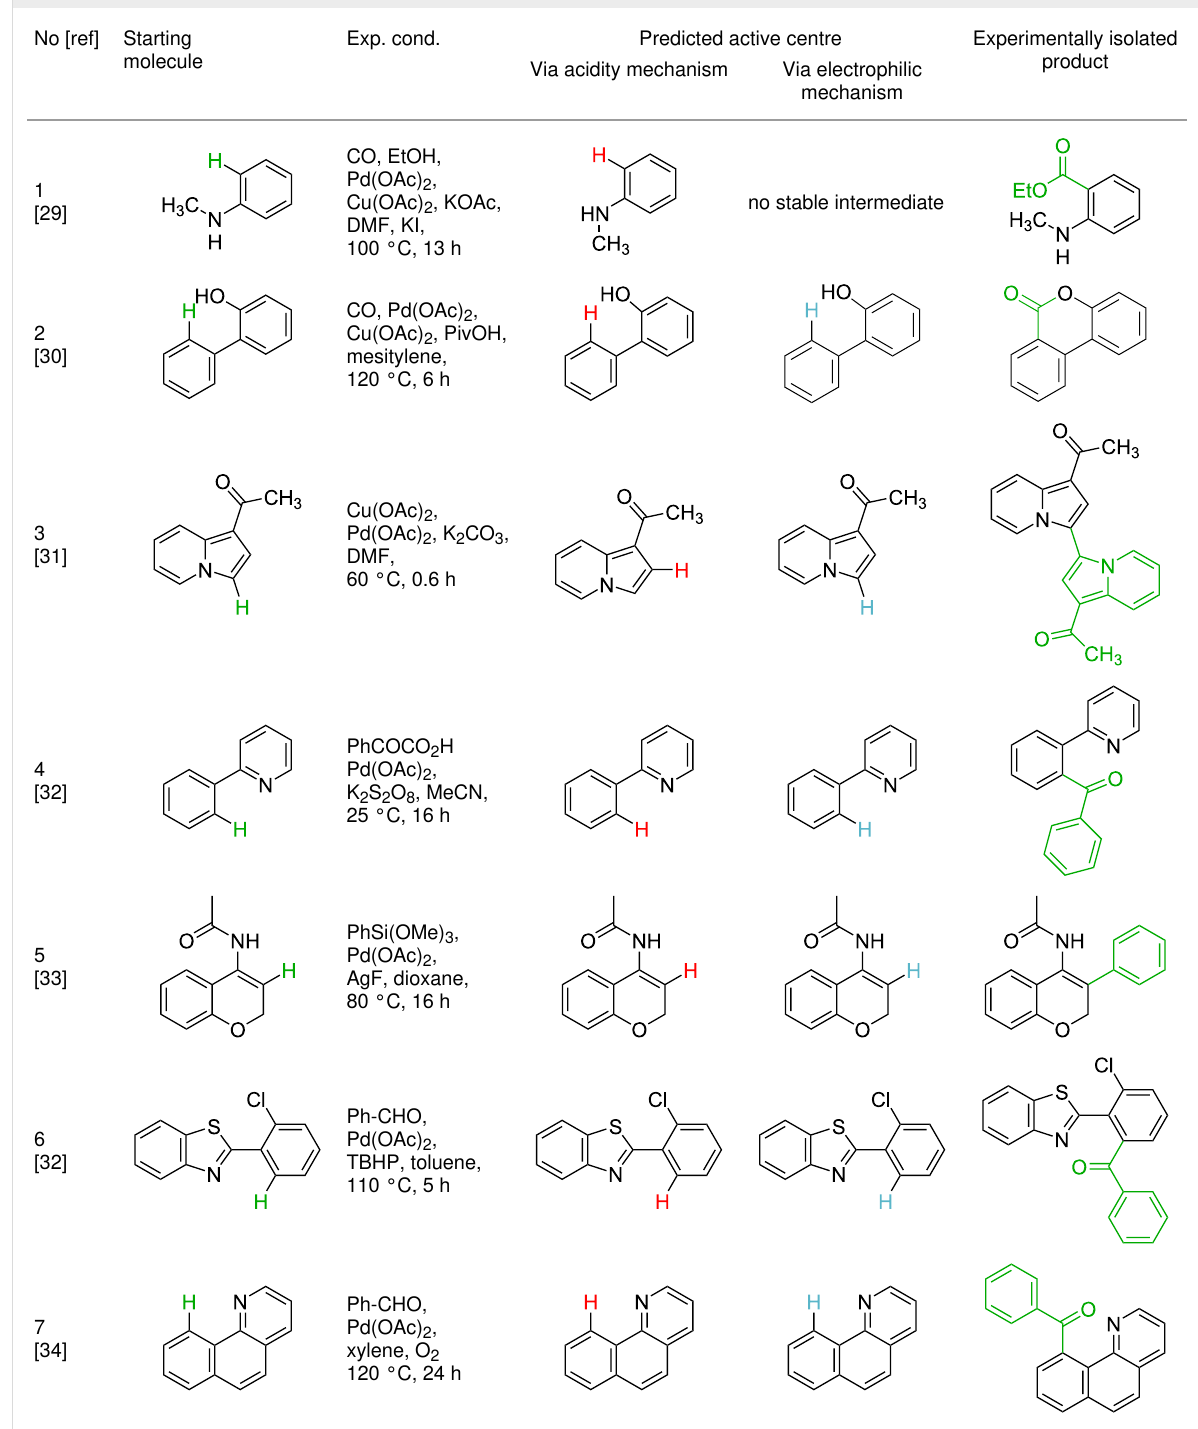
Table 1: Comparison of the published experimental results with the computational predictions for the Pd(OAc) 2 -catalysed reactions. a